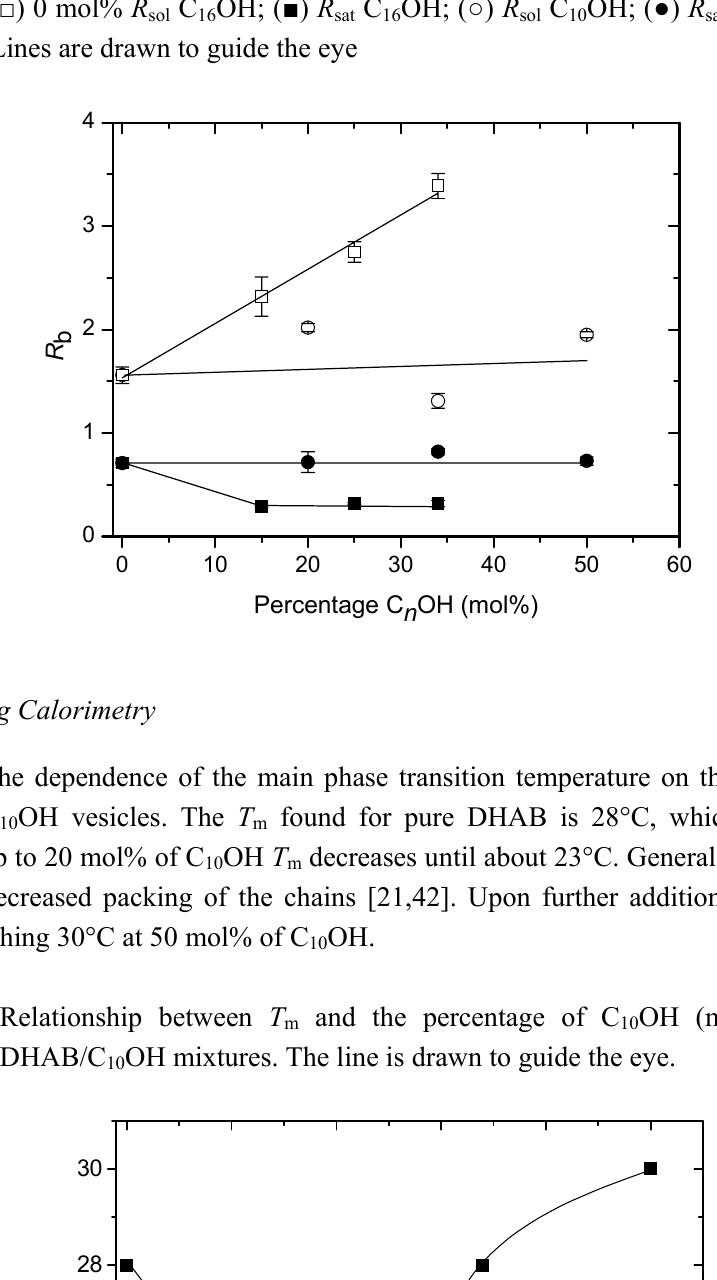
Figure 5. Slopes of Figure 3 and 4 vs. percentage of C